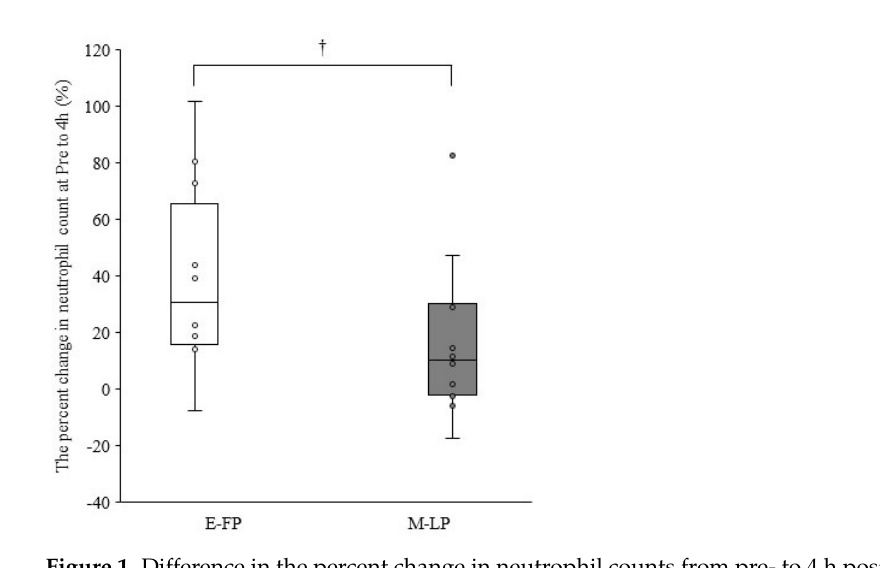
Figure 1. Difference in the percent change in neutrophil counts from pre- to 4 h postexercise in the early follicular phase group (E-FP) and mid-luteal phase groups (M-LP) (median and interquartile range); †, The M-LP tended to be lower than the E-FP ( p = 0.068; effect size = 0.377).